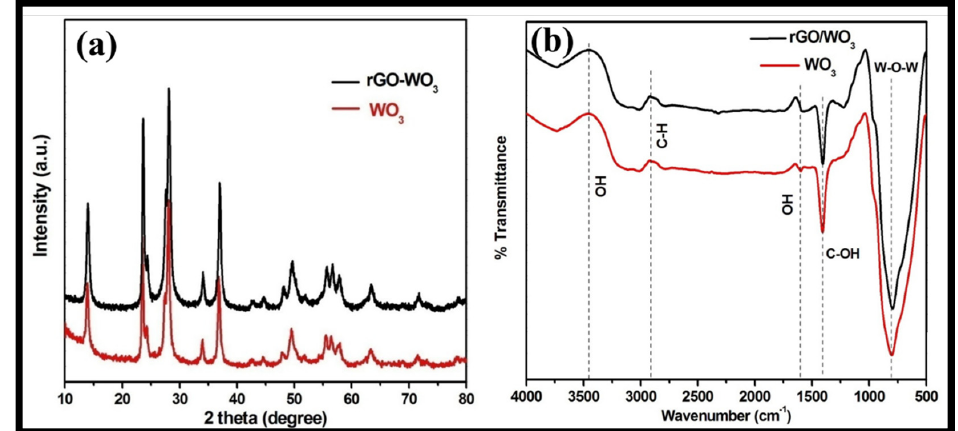
Figure 4. Typical ( a ) XRD and ( b ) FTIR spectra of WO 3 nanorods and the rGO-WO 3 heterostruc-